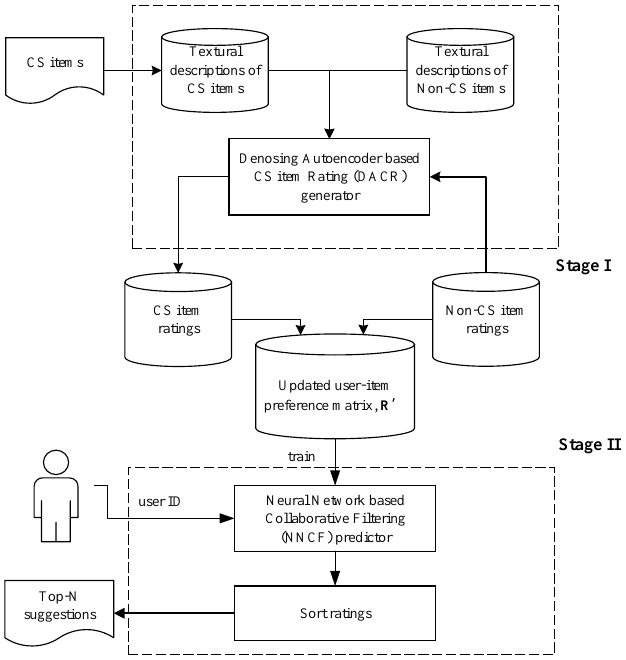
Figure 1. The framework of the proposed cold start item recommendation